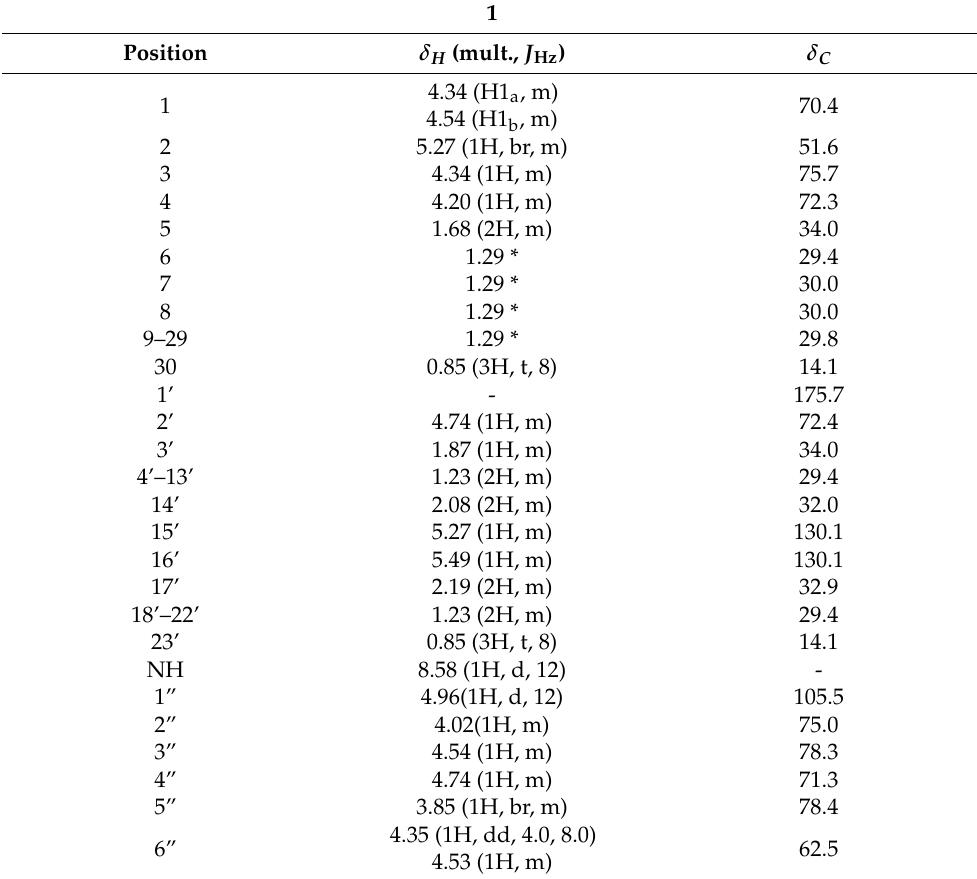
Table 1. 1 H (400 MHz) and 13 C NMR (100 MHz) data for the new compound 1 in C 5 D 5 N.